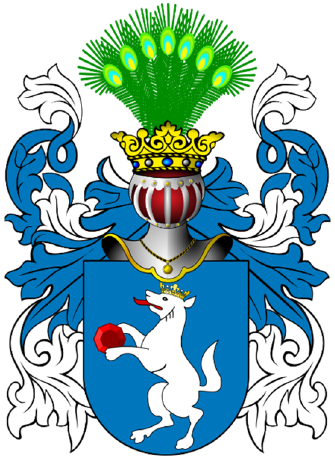
Figure 4. Coat of Arms of the von Flemming family, the one-time owners of Matzdorf (today’s Maciejewo).